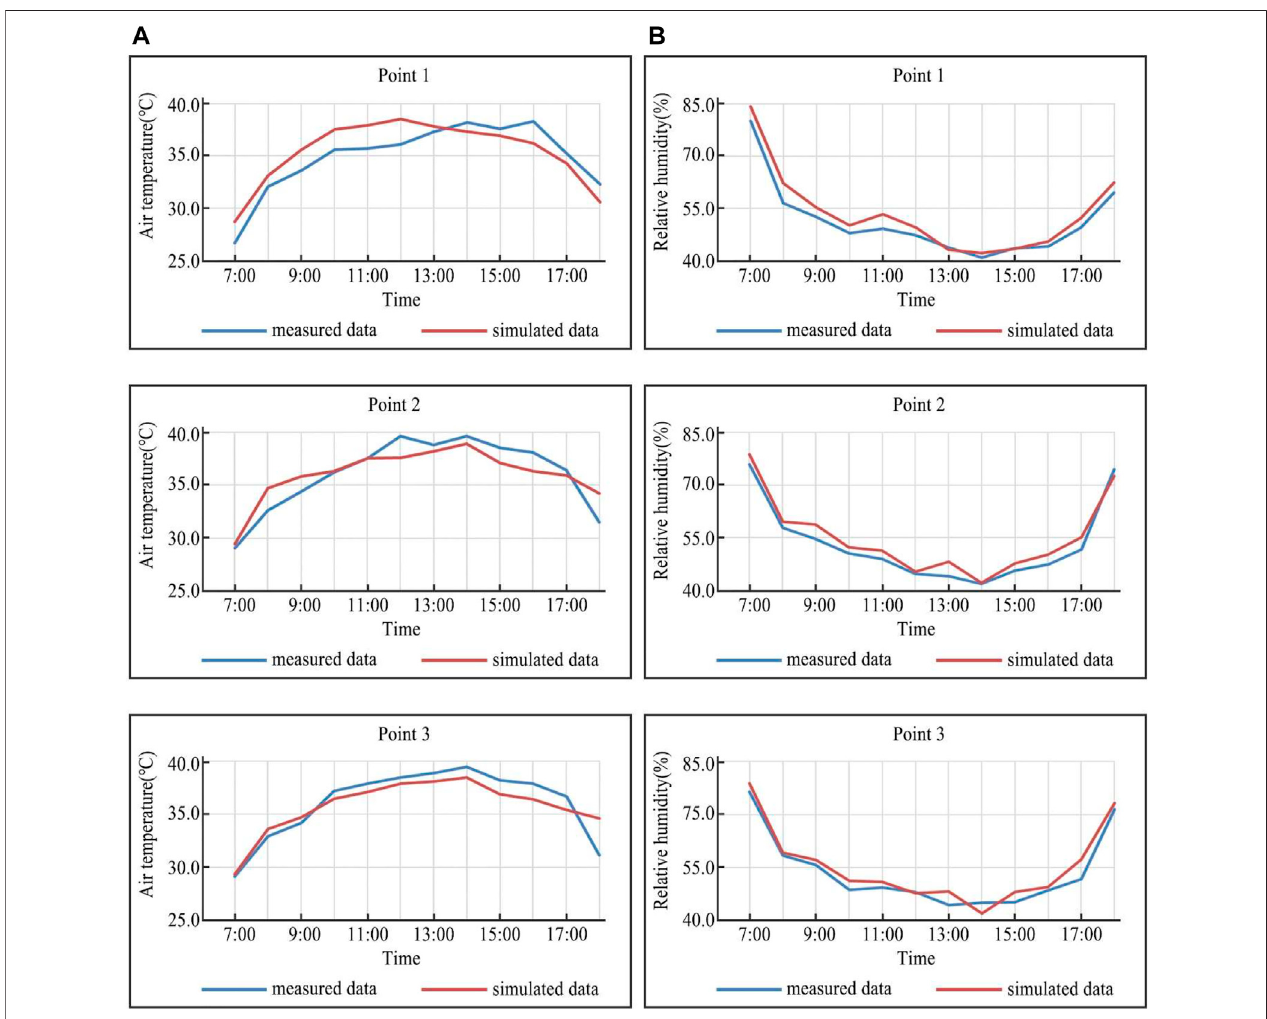
TABLE 3 | The goodness of fi t analysis of measured data and simulated